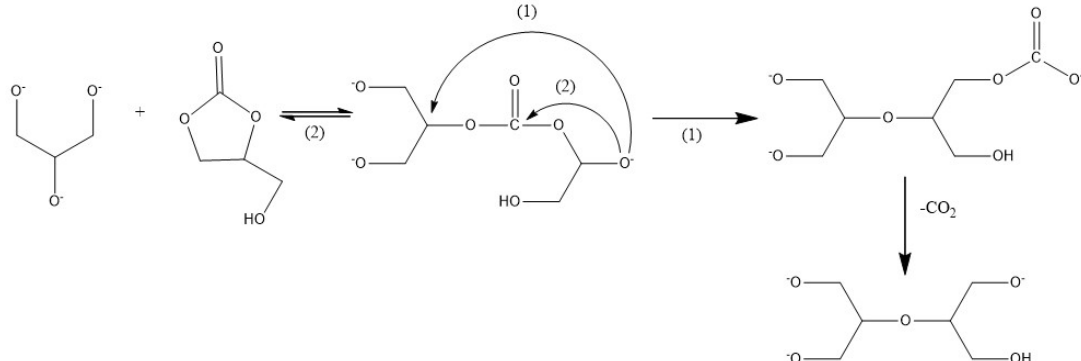
Figure 9. Mechanism of anionic polymerization of carbonate and alcohol (Glycerol)